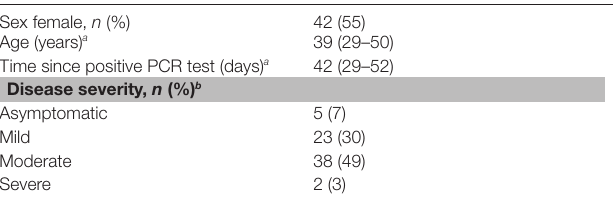
TABLE 1 | Characteristics of Coronavirus disease 2019 (COVID-19) patients ( n = 77).